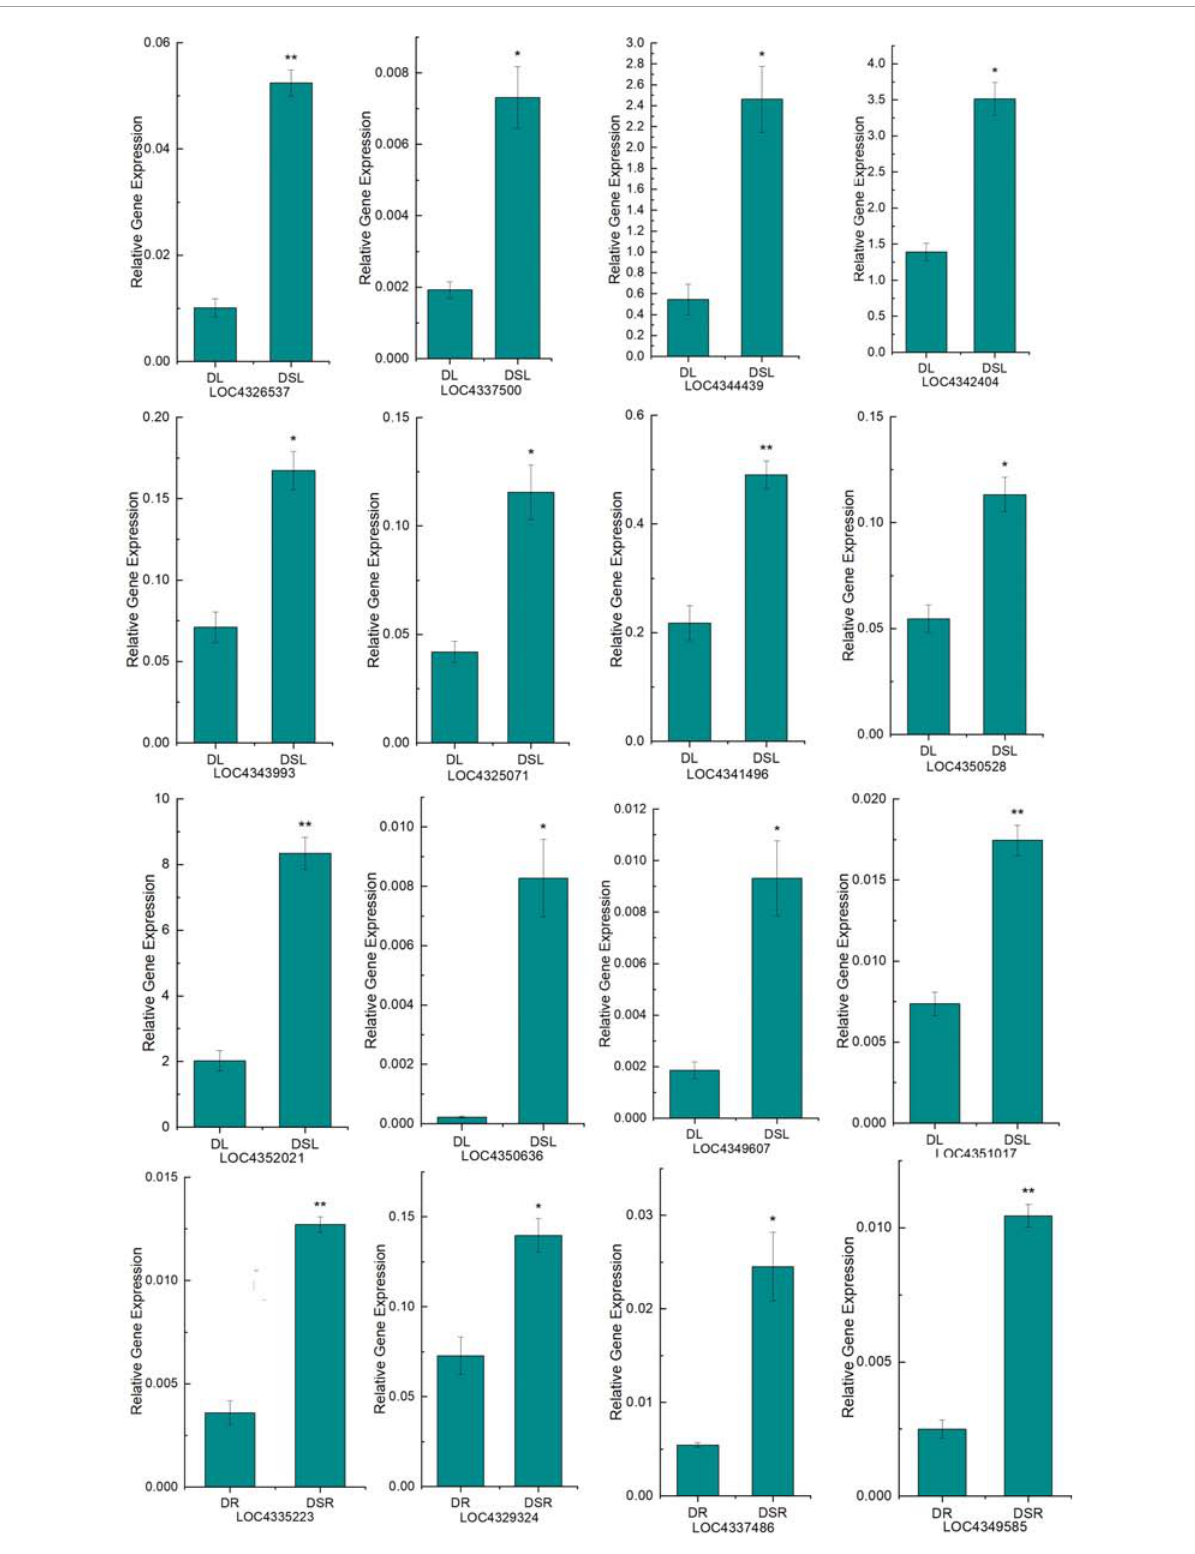
FIGURE5 Quantitative real-time PCR (qRT-PCR) analysis of DEGs. The X -axis represents the treatment, and the Y -axis represents the relative expression of genes. DSL: Silicon-treated of rice under dry cultivation leaves; DL: Normal rice under dry cultivation leaves; DSR: Silicon-treated of rice under dry cultivation root; DR: Normal rice under dry cultivation roots. ∗ P < 0.05, ∗∗ P <